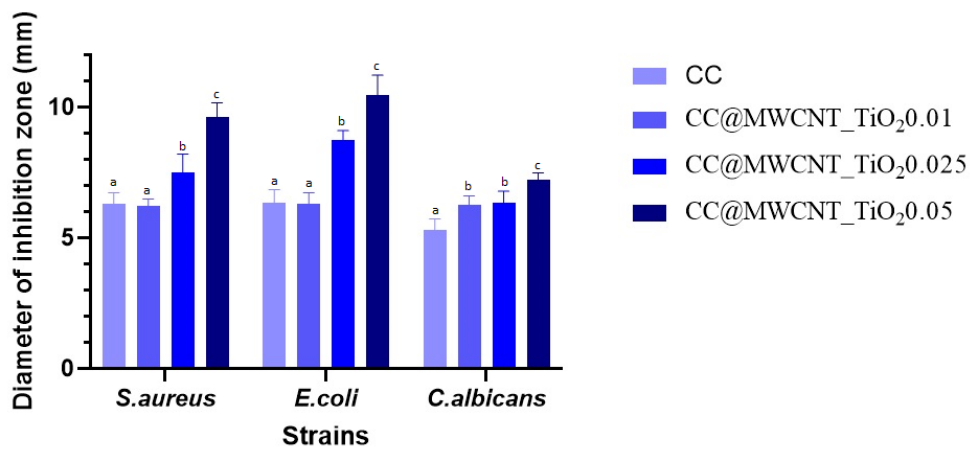
Figure 9. Graphic representation of growth inhibition diameters (mm) obtained after the cultivation of evaluated bacterial strains in the presence of films. Different small letters (a, b and c) indicate statistically significant differences between films ( p < 0.05).